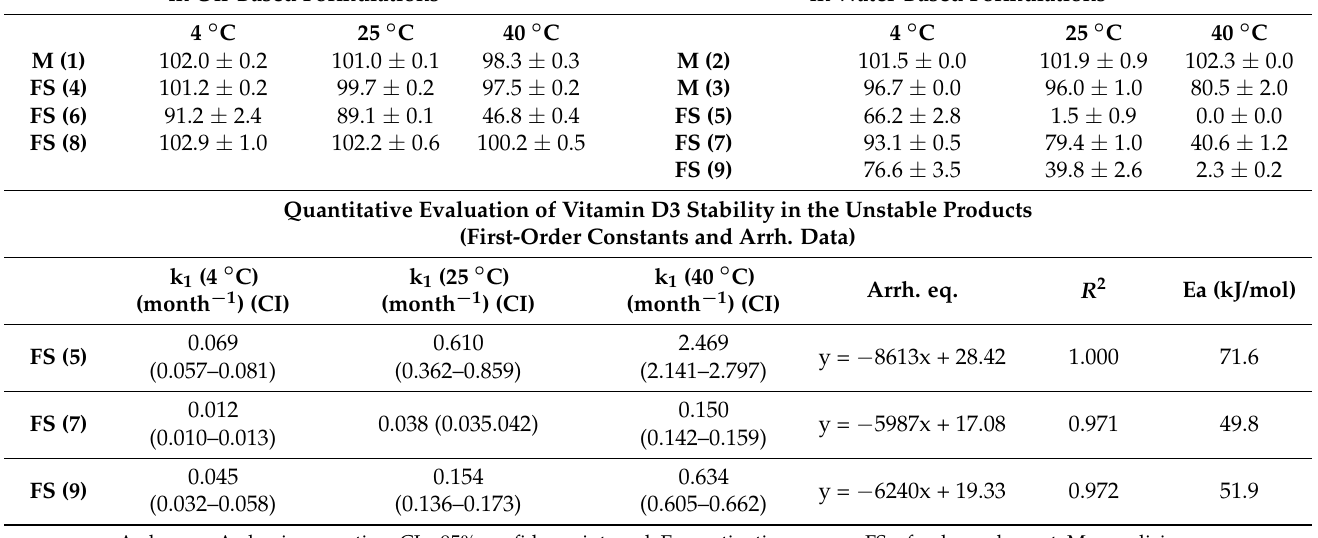
Table 7. Remaining vitamin D3 with respect to initial content in the tested liquid commercial products after 6 months of storage at 4, 25, and 40 ◦ C (average ± relative standard error, n = 3). Vitamin D3 Content (%) after 6 Months in Oil-Based Formulations